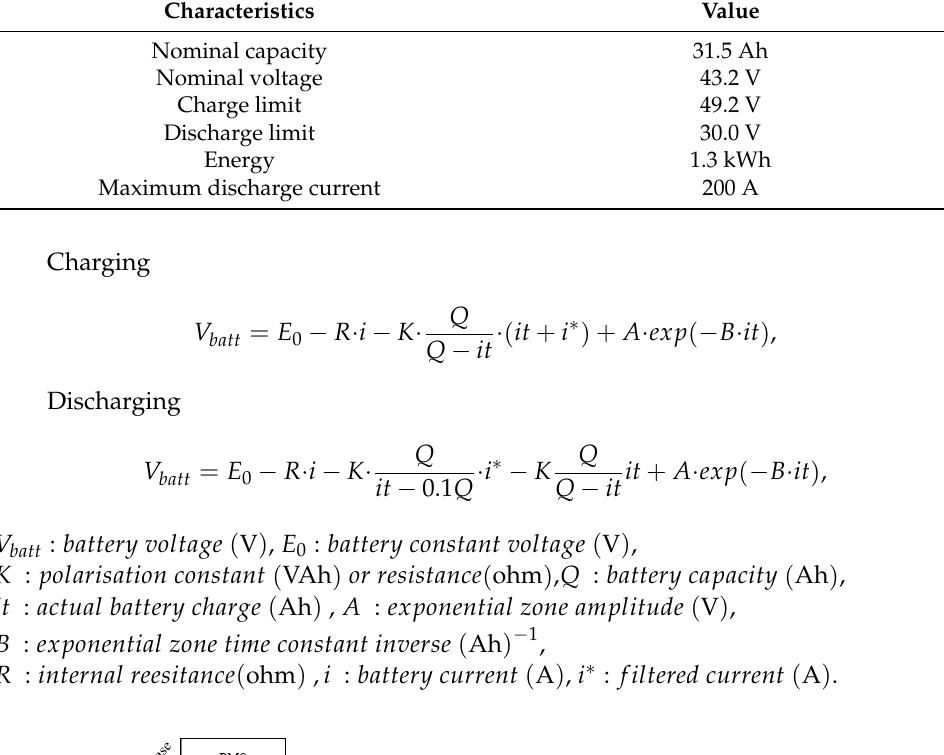
Figure A4. Configuration of the marine systems simulator (MSS). Table A1. Specification of the Li-ion battery cell. Characteristics